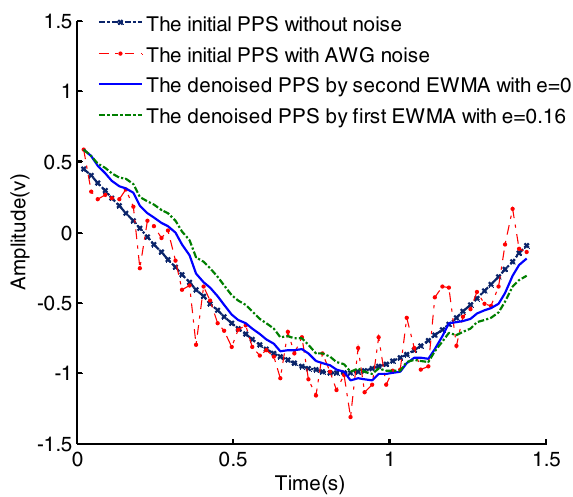
Figure 2. The denoising effects using the first EWMA and the second